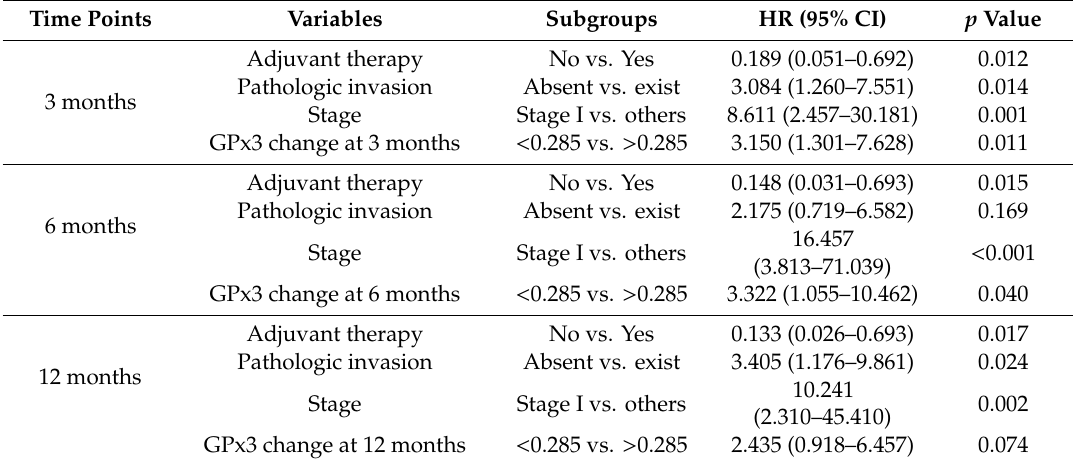
Table 5. Multivariate Cox regression for mean GPx3 change e ff ect on